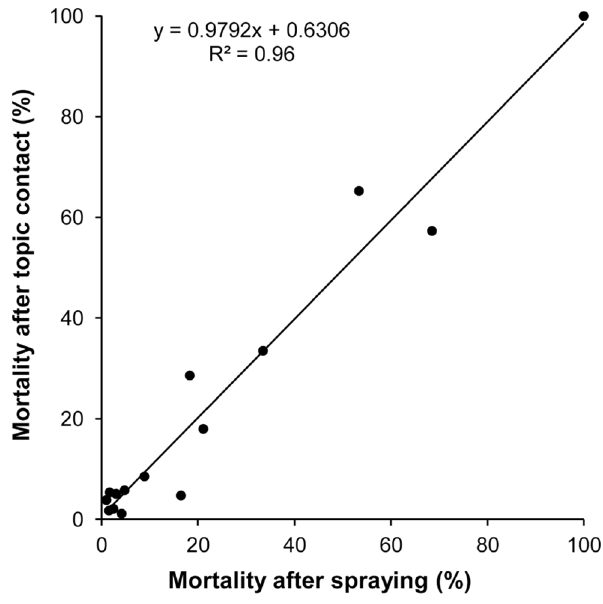
Figure 2. Correlation between mortality induced by spraying and mortality induced by topical treatment. Each dot represents one substance among the 15 tested on bees by thorax topical contact and spraying. The mortality elicited at 48 hours by spraying was given for the chosen field application rate (g a.s./ha) (Table 1). On the basis of the mean exposure surface area (1.05 cm 2 /bee), the application rate (g a.s./ha) was converted into an individual dose (ng a.s./bee) to treat the bees topically. The dose-mortality relationship at 48 hours was modeled for each of the 15 active substances, which enabled assessing the mortality that could be induced at a given field exposure.